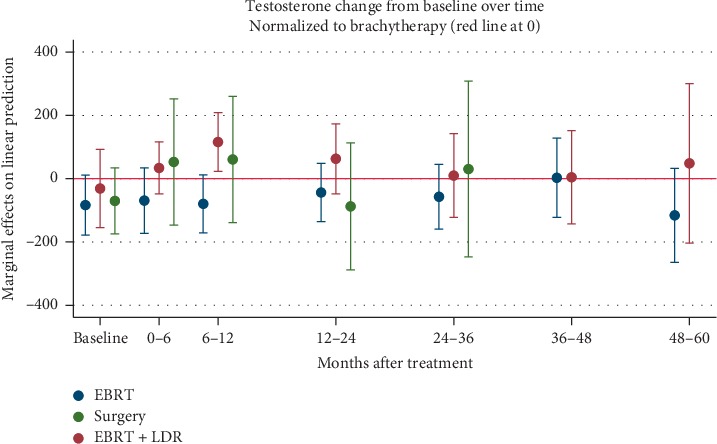
Marginal effects modelling of mean changes of testosterone over time by treatment cohort, normalized to 0 for the baseline mean of the brachytherapy cohort. Error bars represent standard deviations from the mean.